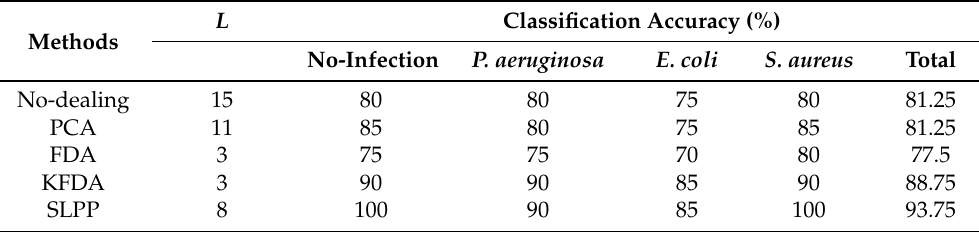
Table 8. Classification results of 40-fold using different data processing methods (KNN).